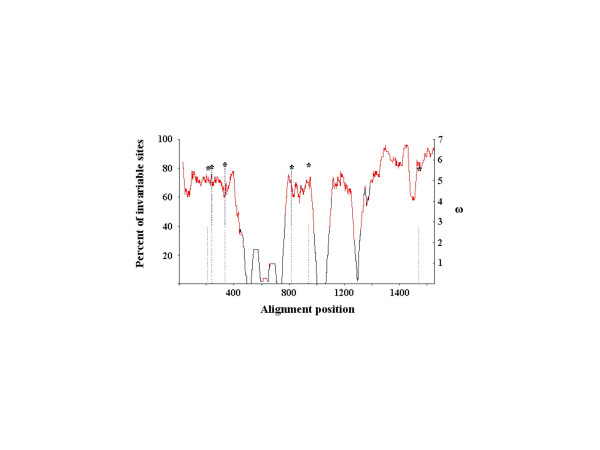
Variable selective pressure along the Sca1 sequences. The x axis represents the alignments of the Sca1 sequences. The predicted passenger and autotransporter domains expand from positions 1 to 800, and from positions 801 to the end, respectively. The N-terminal signal peptide is not included in the alignment because the sequence was not determined for some of the Rickettsia species under study. The y axis represents the percent of invariable sites per window of 50 sites attributed to each amino acid position in the Sca1 protein alignment. Predicted positively selected sites and their mean of ϖ (calculated as the average of ϖ over the 11 site classes of model M8, weighted by the posterior probabilities; right axis) appear as stars. The curve represents the averages of means of ϖ calculated for sliding windows of 50 codon sites (right axis).